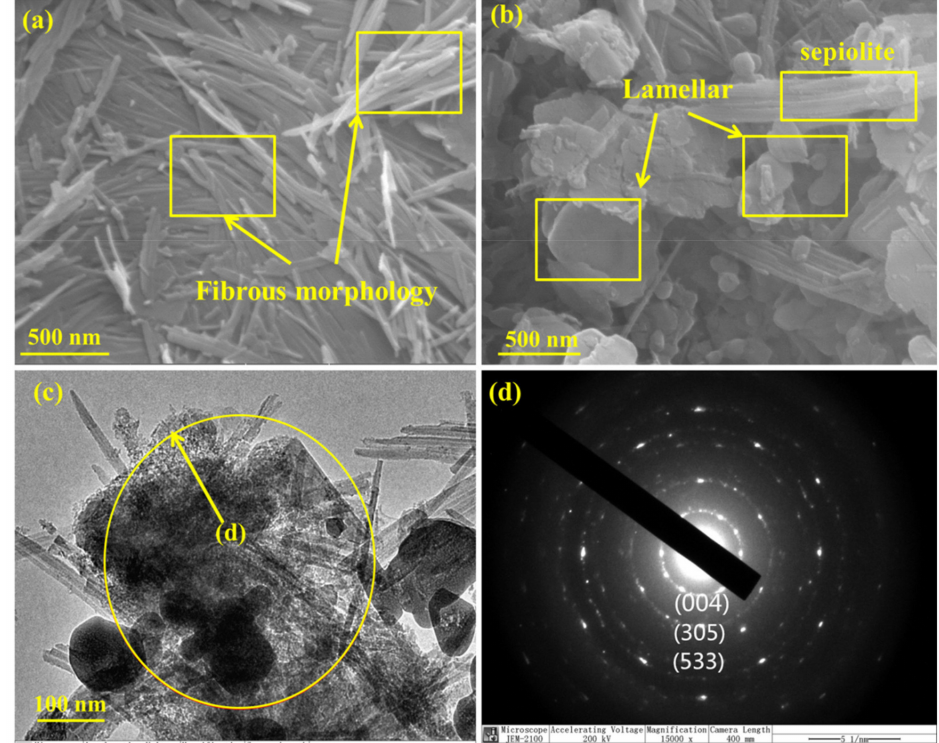
Figure 3. ( a , b ) SEM images of sepiolite and SMN-3; ( c ) TEM image of SMN-3; ( d ) the selected area electron diffraction